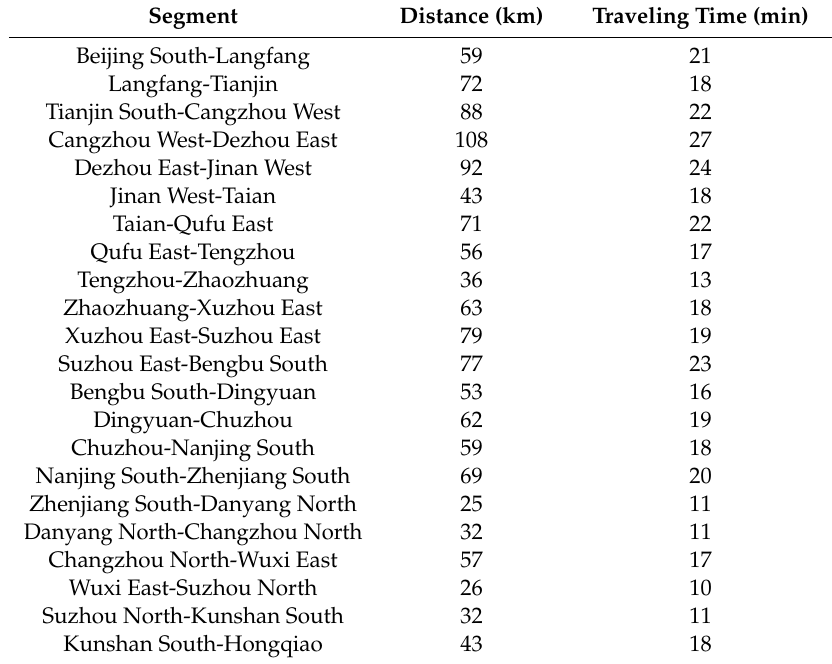
Table 11. Distance and traveling